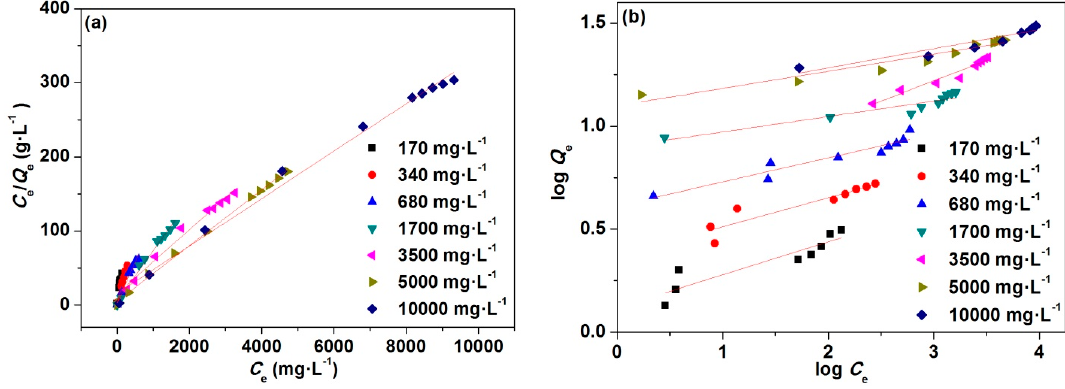
Figure 5. ( a ) Langmuir and ( b ) Freundlich isotherms of iron adsorption by Rexp-501 at 298 K. Table 1. Fitting results of Langmuir and Freundlich isotherms ( R 2 is the correlation of determination). Langmuir Isotherm Concentration (mg·L − 1 )